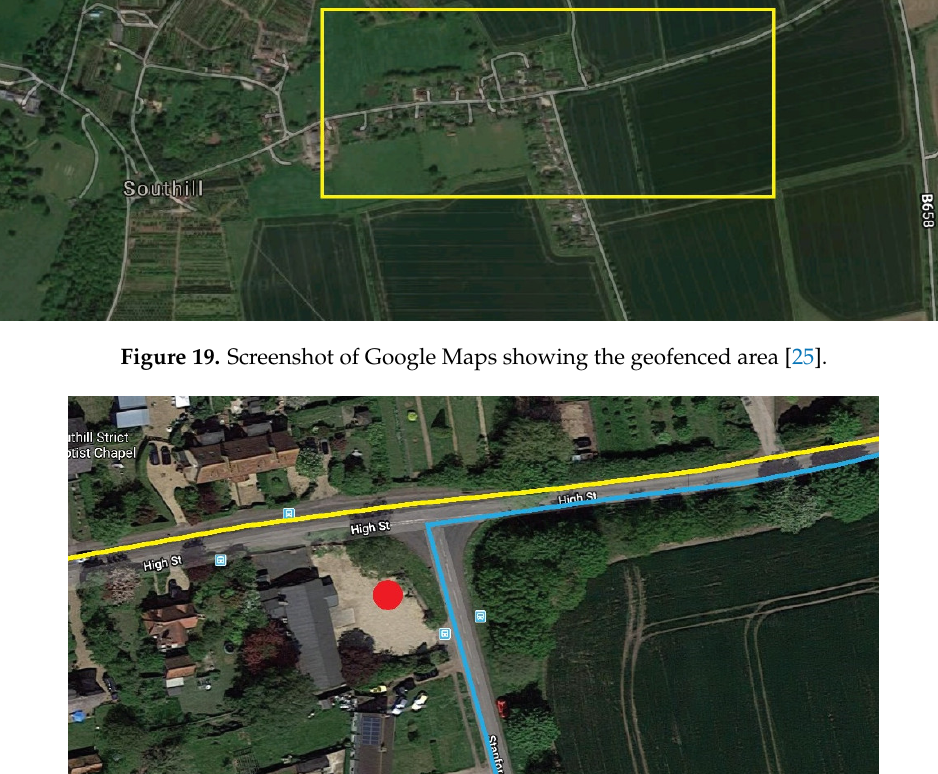
Table 6. Number of Coordinates Collected during each experiment.